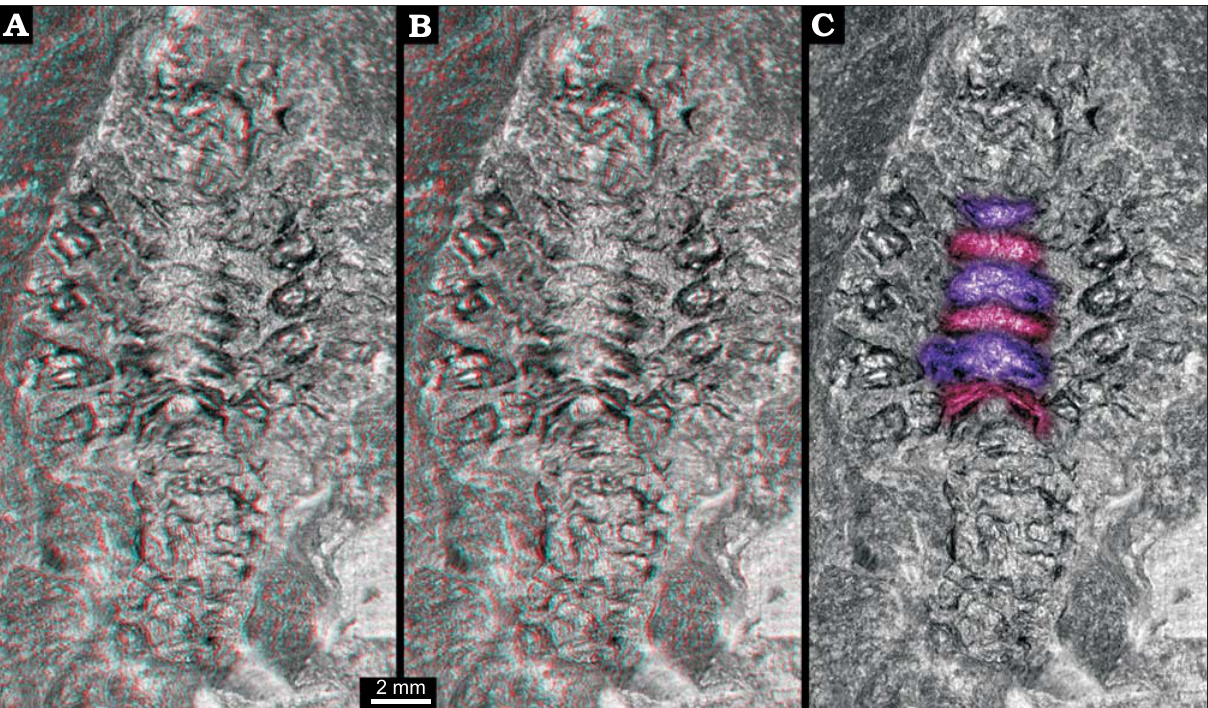
Fig. 2. Larva of Achelata gen. et sp. indet. (SMNS 70449), Toarcian, Lower Jurassic, Gomaringen, Southern Germany. A . Stereo-image showing original relief of the fossil; based on virtual surface. B . Depth-inverted stereo-image showing morphologically correct relief in ventral view. Please use red-cyan glasses to view A and B. C . Non-stereo image; colour-marked are the elevations of the thoracic